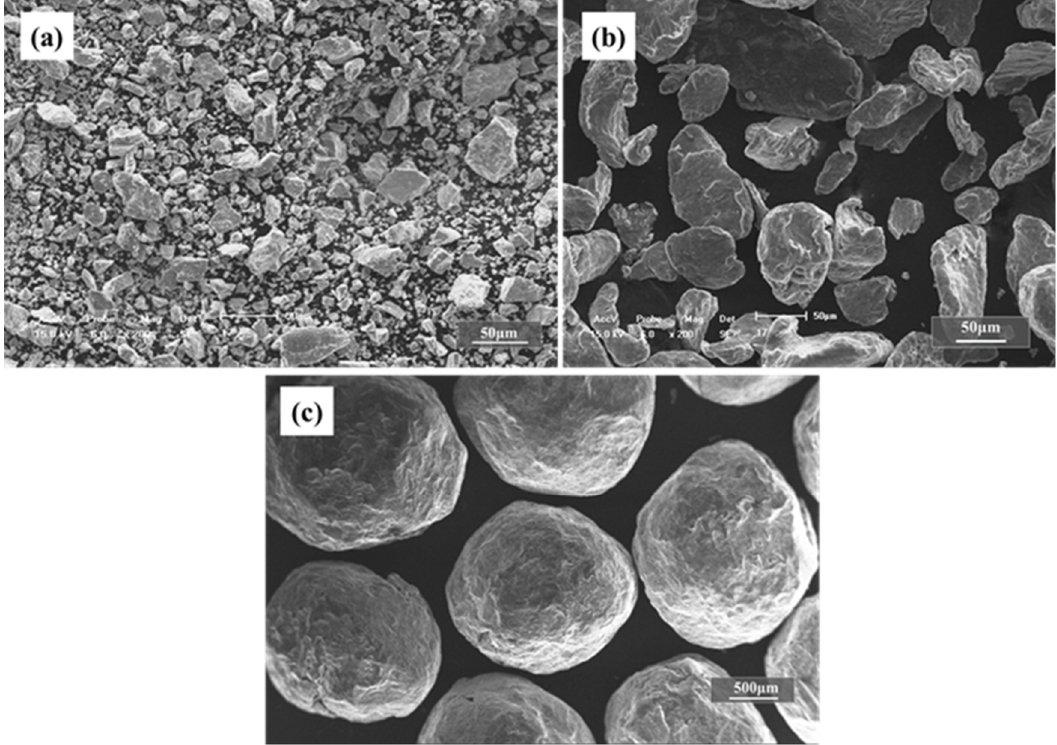
Figure 1. SEM images showed m orphologies of Ti powders ( a ), Mg powders ( b ) and Mg particles ( c